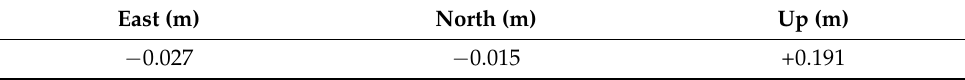
Figure 2. Fixed control point (FCP) and equipment placement. Table 1. Offset of smartphone antenna phase centre with respect to